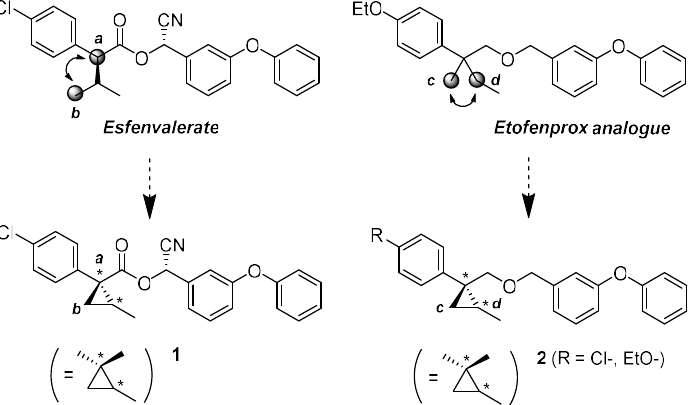
Figure 2. Chiral synthetic cyclopropane-type pyrethroids with one and three chiral centers on the cyclopropane ring.